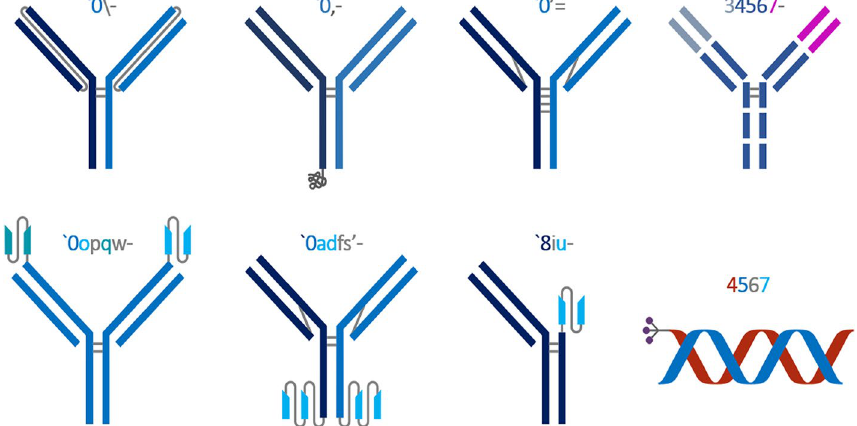
Fig. 4 Glyphs for select large molecule constructs created using